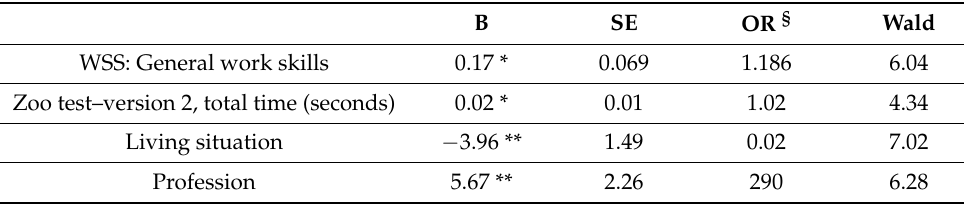
Table 4. Odds ratio for work